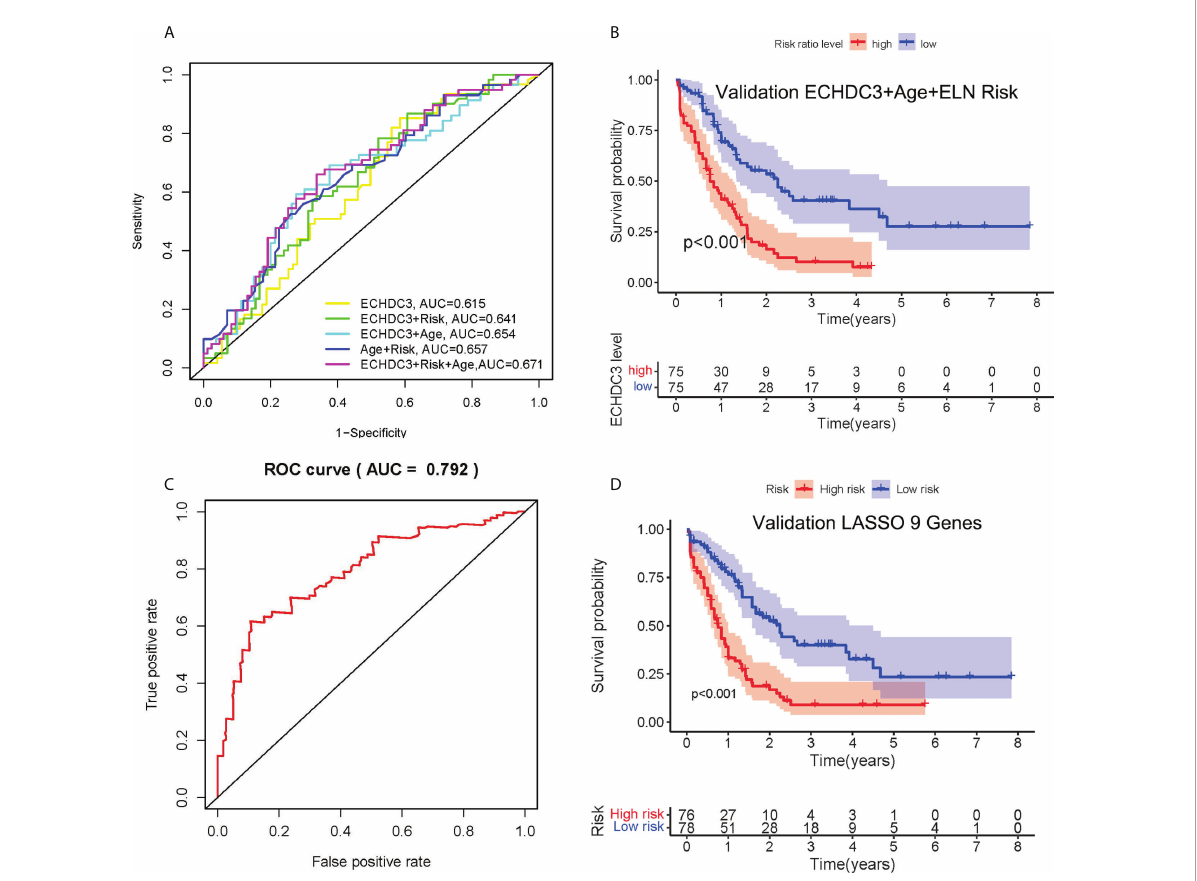
FIGURE 4 Combination of ECHDC3 and other risk factors in the prediction. (A) Time-dependent ROC analysis by combination of ECHDC3+age+ELN risk (B) Overall survival comparing high vs . low risk in the new model of ECHDC3 + age + ELN risk. (C) Time-dependent ROC analysis in the new model by LASSO regression. (D) Overall survival comparing high vs . low risk in the new model by LASSO